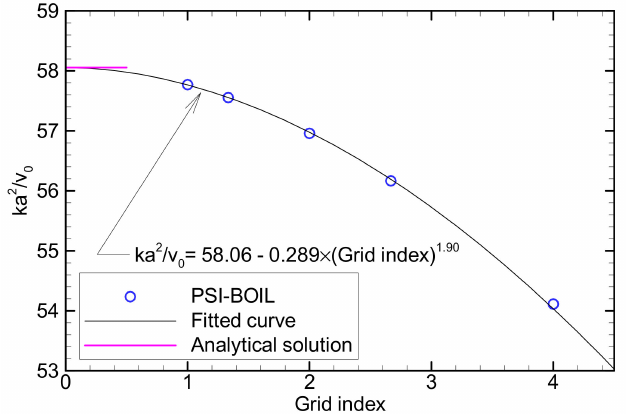
Figure 2. Grid dependency study for Ha channel = 50, indicating the 1.9th-order accuracy in spatial discretization.